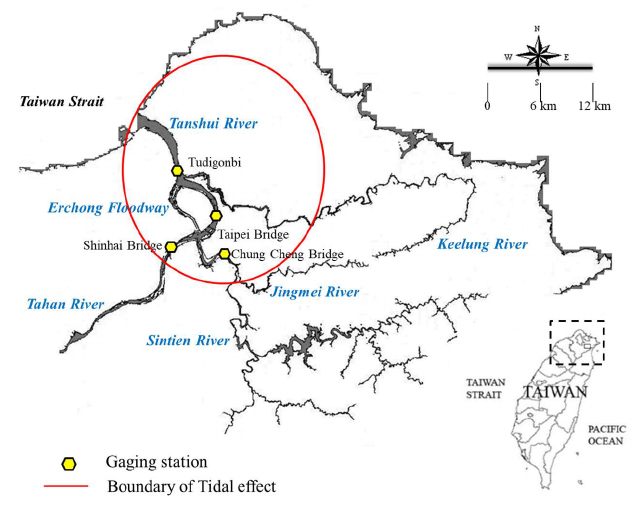
Figure 3. Study area and gauging stations.